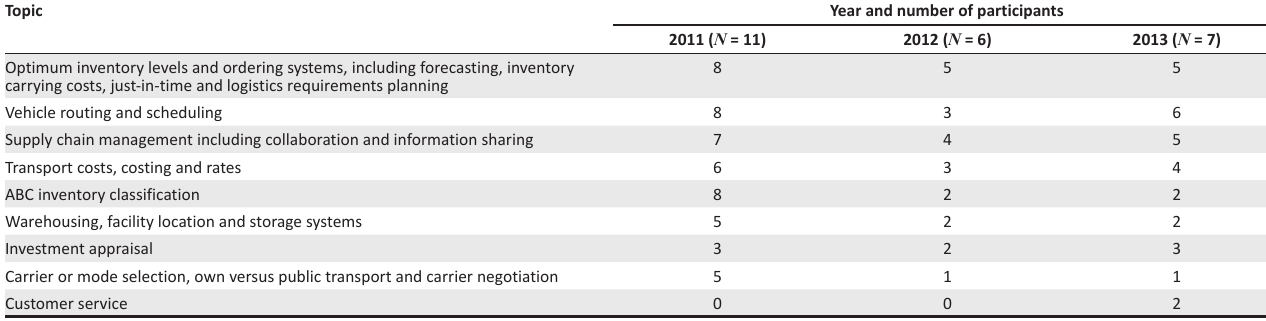
TABLE 5: Most valuable topics mentioned in response to an open-ended question.